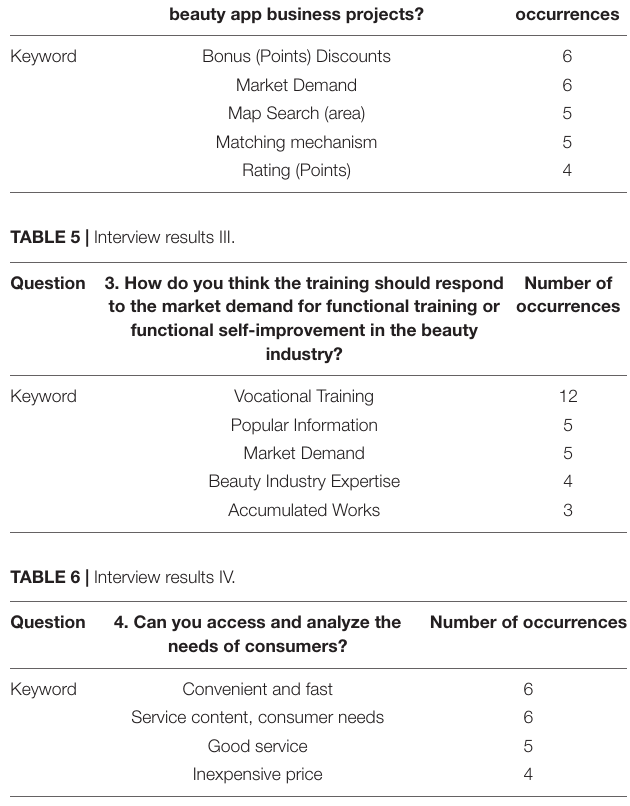
TABLE 4 | Interview results II.